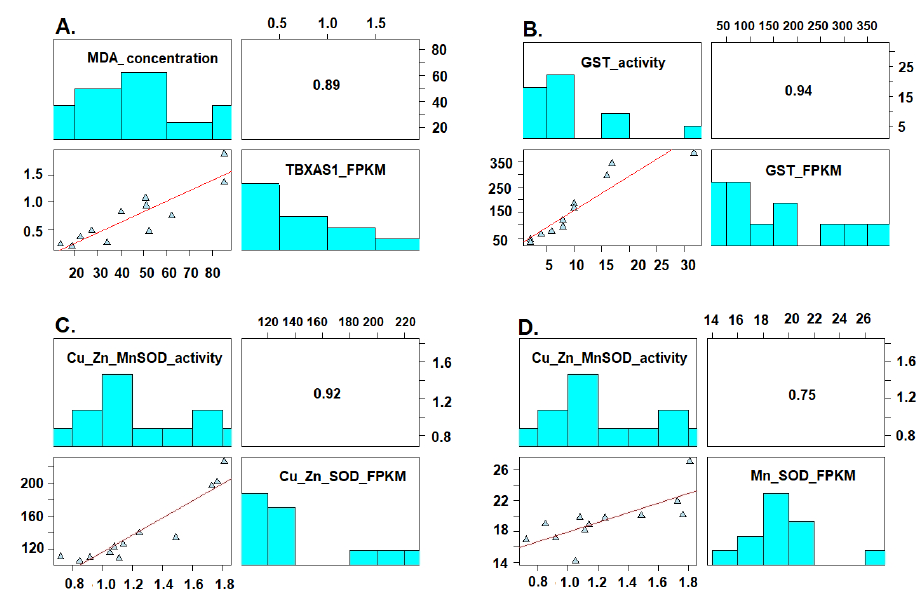
Figure 8. Correlation between the enzymatic activity of GST, SOD, and the concentration of MDA ( µ M) produced by lipid peroxidation with the relative expression (FPKM) of the genes in the loggerhead turtle, exposed to MeHg. ( A ) TBXAS1 with MDA (µM), ( B ) GST with GST activity, ( C ) Cu/Zn-SOD with Cu/Zn-SOD activity, ( D ) Mn-SOD with Mn-SOD activity.